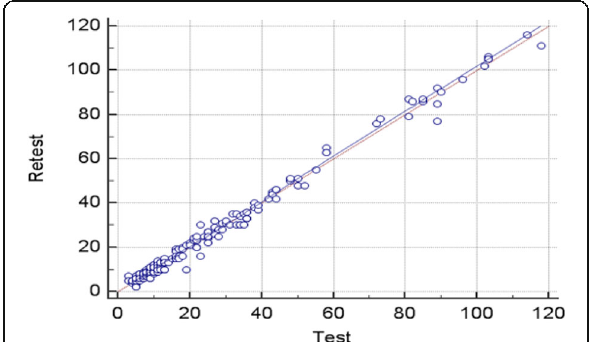
Fig. 2 Scatter diagram for concordance correlation coefficient showing that there was no significant deviation from the 45 ′ line of concordance, which indicate almost perfect degree of reliability. Red line indicates line of equality. Blue line indicated the trend line (loess smoothing) (span 80%)